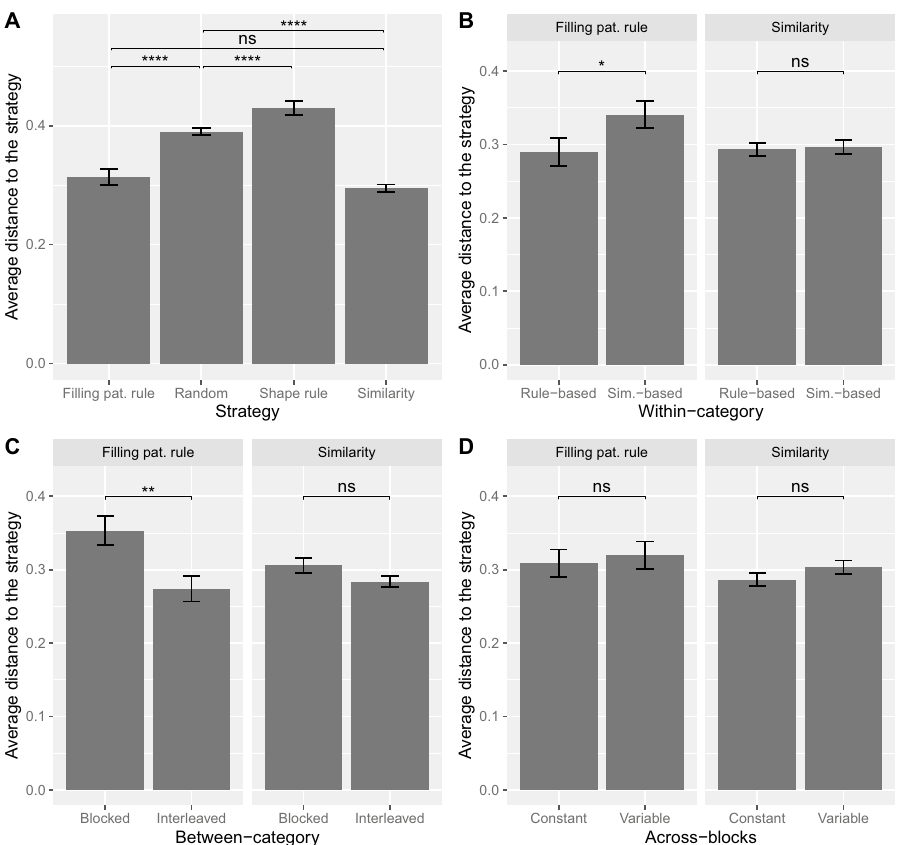
Figure 9. Average distance of participants’ generalization patterns on novel stimuli to specific strategies (rule- based strategy using Filling pattern, rule-based strategy using Shape, similarity-based strategy, and random strategy), for all participants ( A ) and for each type of order within the same manipulation ( B , C , D ). Distances were first computed for each participant before being averaged. The L 1 norm was used and distances were normalized prior to averaging. Asterisks show the significance of the two-sided Wilcoxon-Mann-Whitney